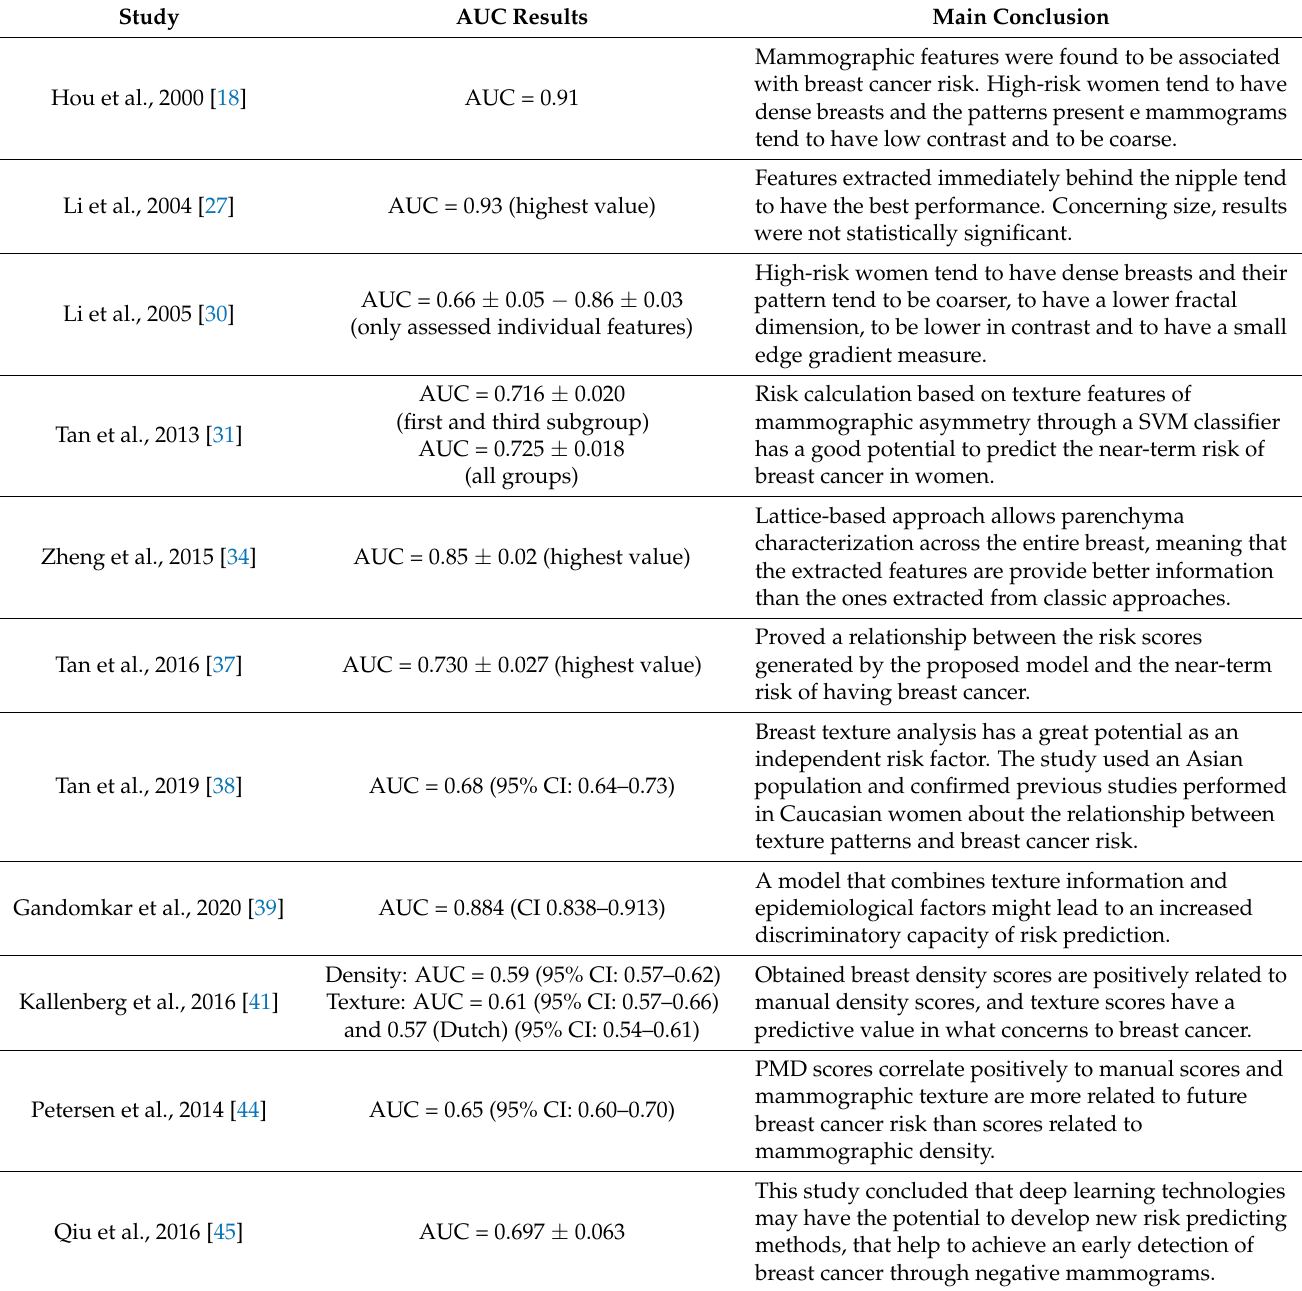
Table 3. Results